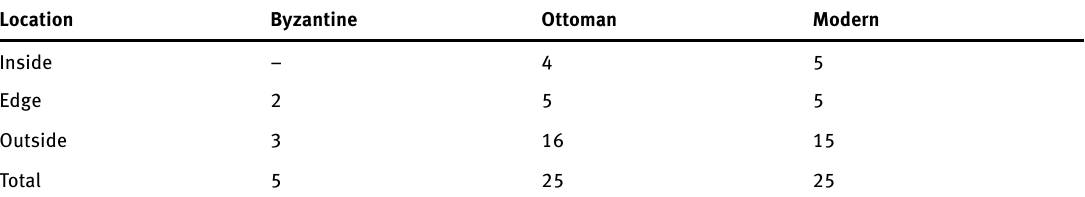
Table 5. Monastery Churches by Period of Use and